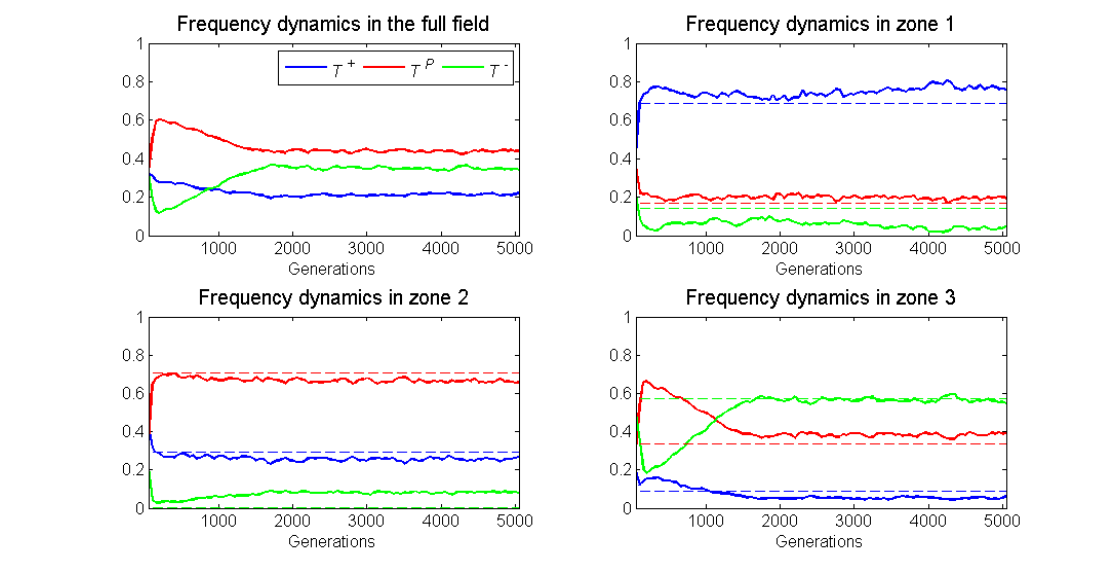
Figure 5. Frequency dynamics (of a single run) of the spatial game in across the entire torus (top, left). For the other three panels, the dotted lines show the ESS frequencies of the respective matrices A 1 , A 2 , and A 3 . In this case, an isolated cell cannot proliferate and the blood vessel remains fixed in its location.